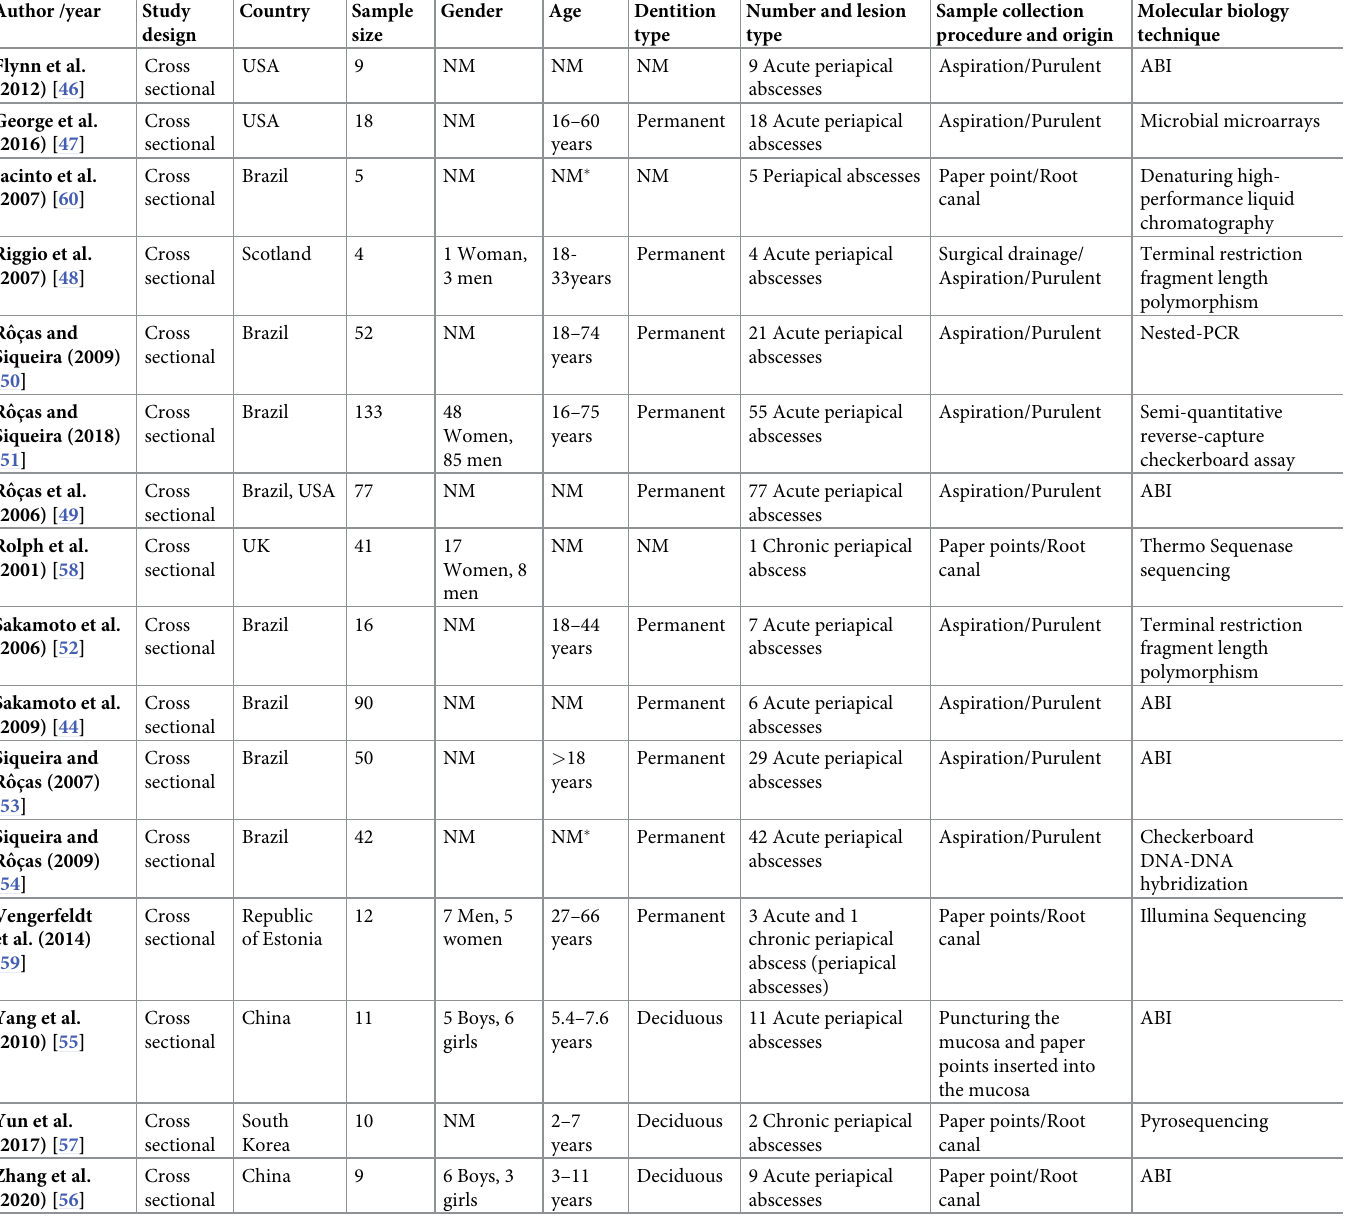
Table 1. General characteristics of the included